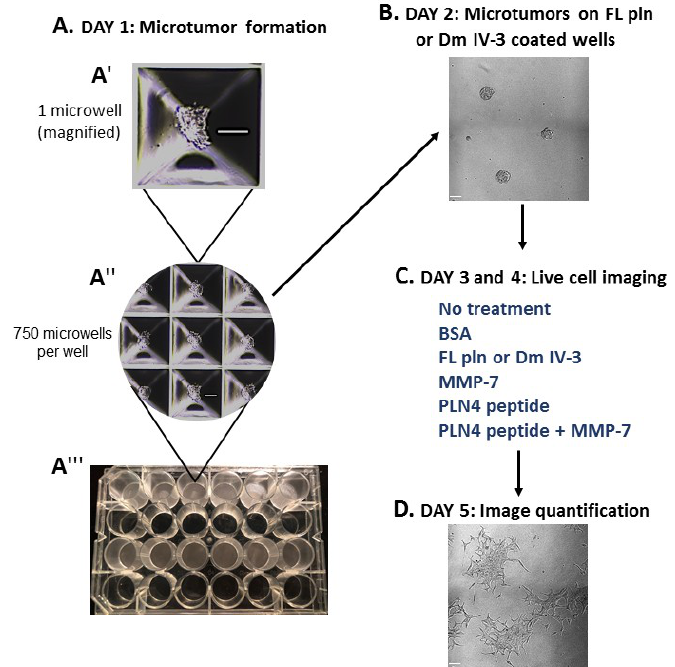
Figure 4. Microtumor formation assay. To evaluate the impact of FL pln, MMP-7 and PLN4 peptides on microtumor dispersion, uniformly sized C4-2 microtumors were pre-formed using a 24-well plate microwell system (Kugelmeiers AG. Zürich, Switzerland) (A) . One single well of a 24-well plate contains 750 microwells that allowed us to form 750 microtumors of approximately 133 cells per microtumor (A’) , (A’’) . These pre-formed microtumors were transferred to FL pln or Dm IV-3-coated wells for ~24 hours (B) . Next, microtumors were transferred again to uncoated wells or collagen I-coated wells, and the indicated consecutive treatments in C (blue text) were added to the cell culture media. Live-cell imaging (D) stopped at ~48 hours and cell dispersion area was quantified (see Figure 5). Scale bars: 100 µm.